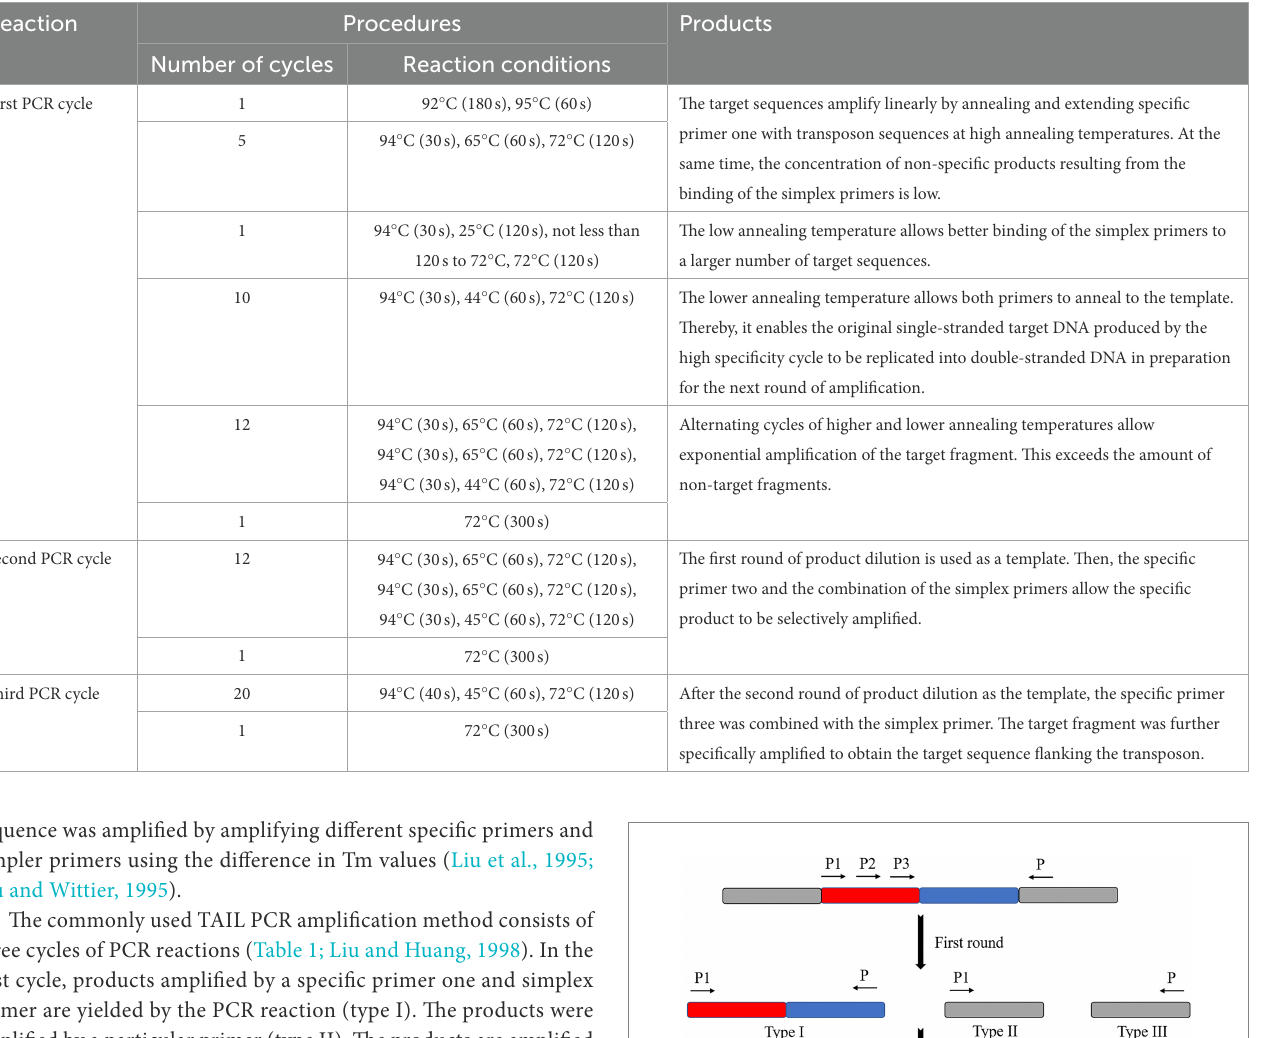
target fragment (type I product), the fragment amplified by the specific primer itself (type II product), and the fragment amplified by the